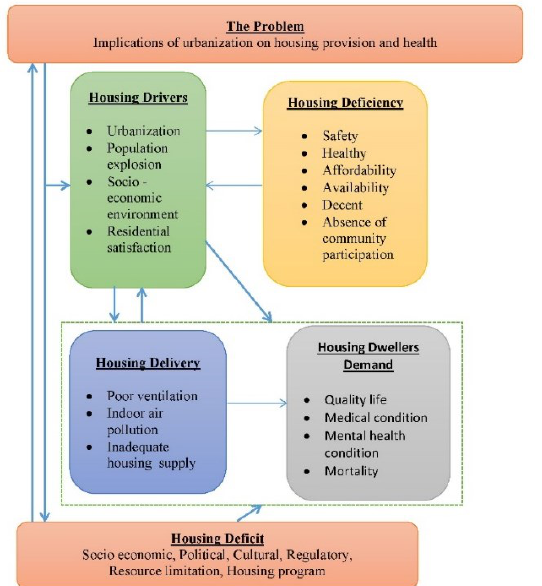
Figure 1. Conceptual framework to assess implications of urbanization on housing and health (Developed by